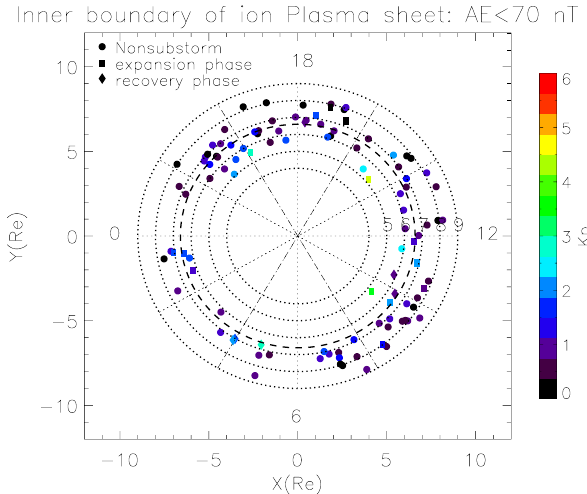
Fig. 4. The scatter plot of inner boundary of ion plasma sheet de- tected by TC-1 in the X-Y GSM plane color-coded according to AE index. The symbols of circle, square and diamond represent non- substorm, expansion and recovery phases of substorm, respectively.